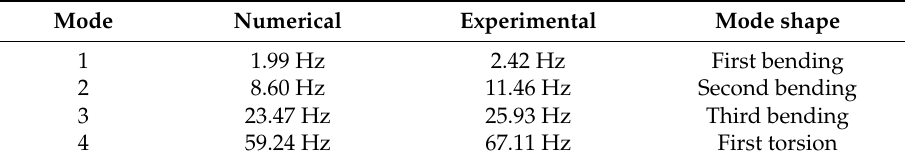
Table 1. Comparison of numerical and experimental natural